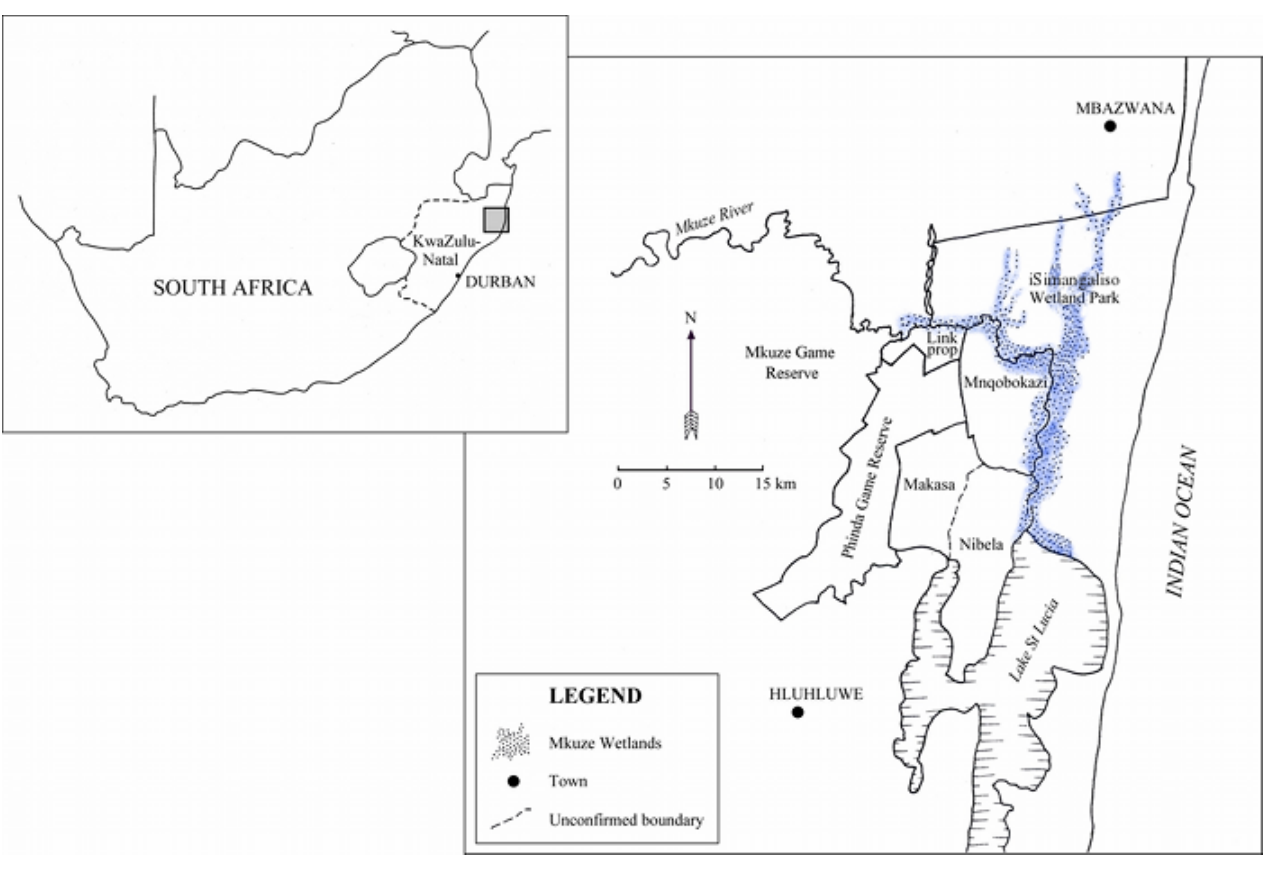
Figure 1. Location of study area (modified from Andrén